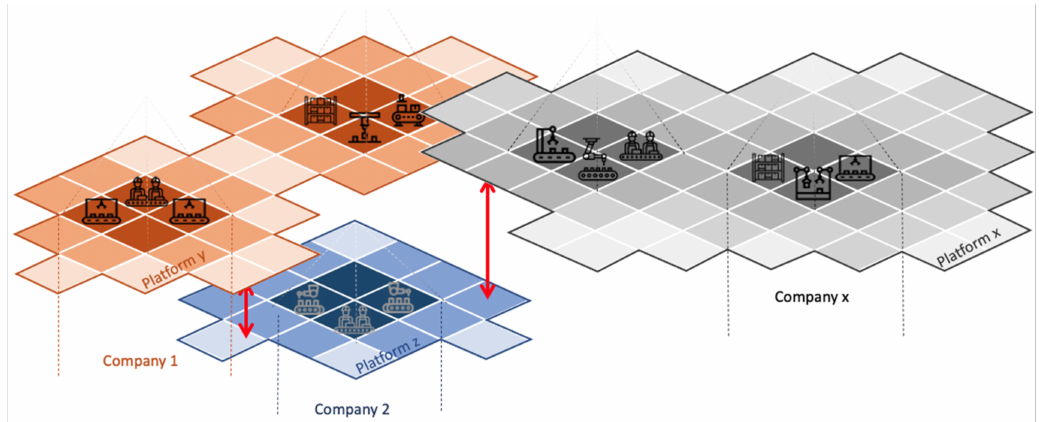
Figure 1. Gaps in the manufacturing